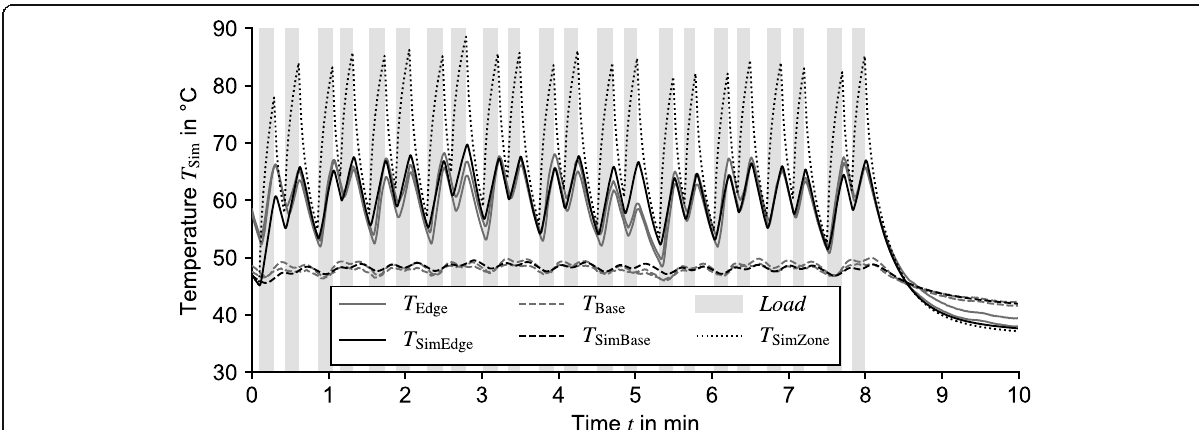
Fig. 10 Temperature simulation for Wet White during shaving. The black curve represents the simulated temperature T SimEdge and corresponds to the grey curve of the measured temperature T Edge . The black dashed curve represents the simulated temperature T SimBase near the roller base and corresponds to the grey dashed curve of T Base . The dotted black curve displays the simulated temperature in the contact zone T SimZone . The grey shaded vertical bars indicate when the machine is under